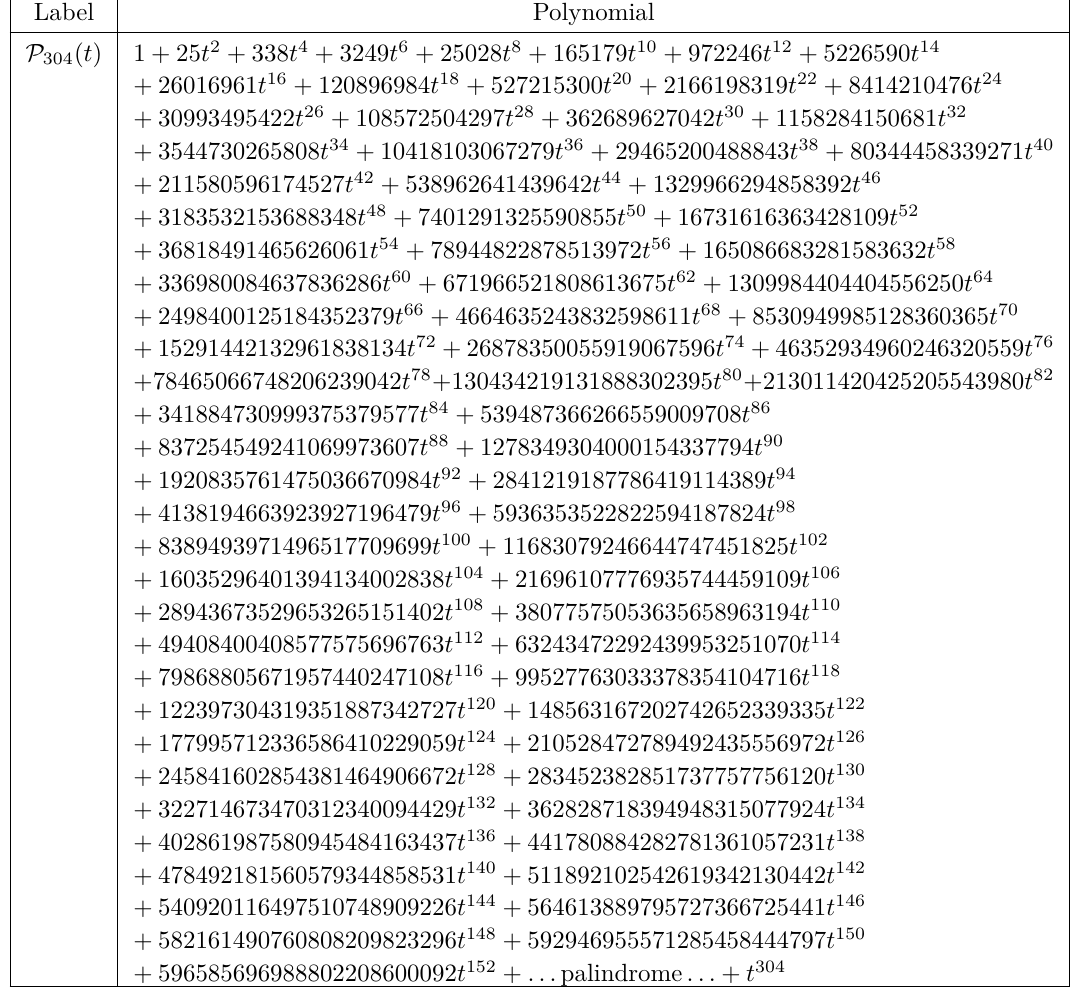
Table 42. Palindromic polynomials